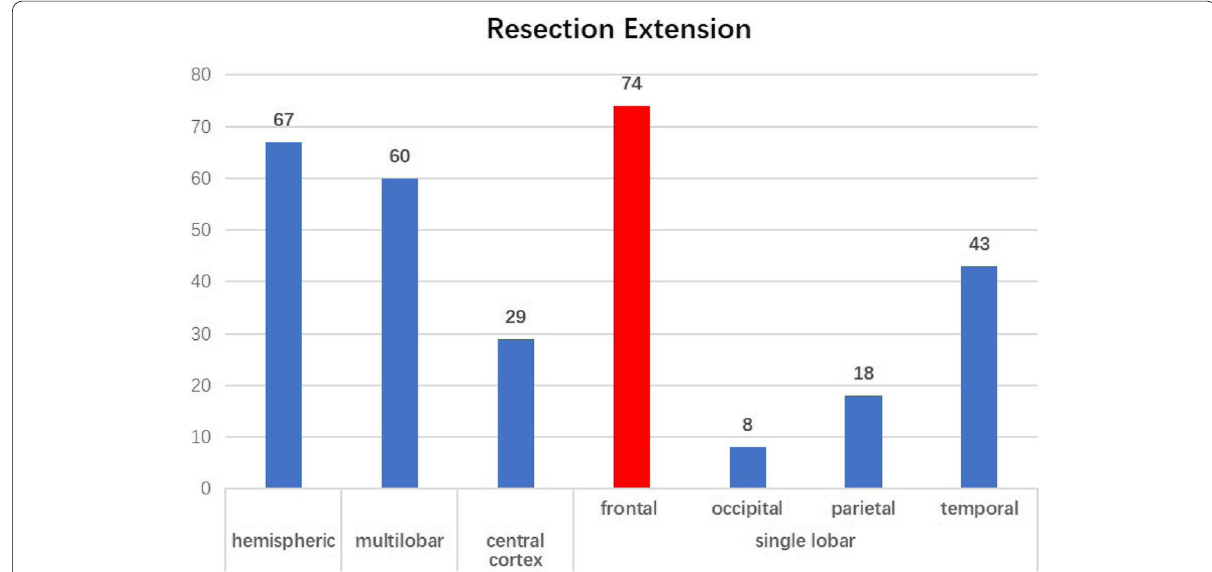
Fig. 1 Resective extension of 299 epilepsy cases receiving resective surgery at the same